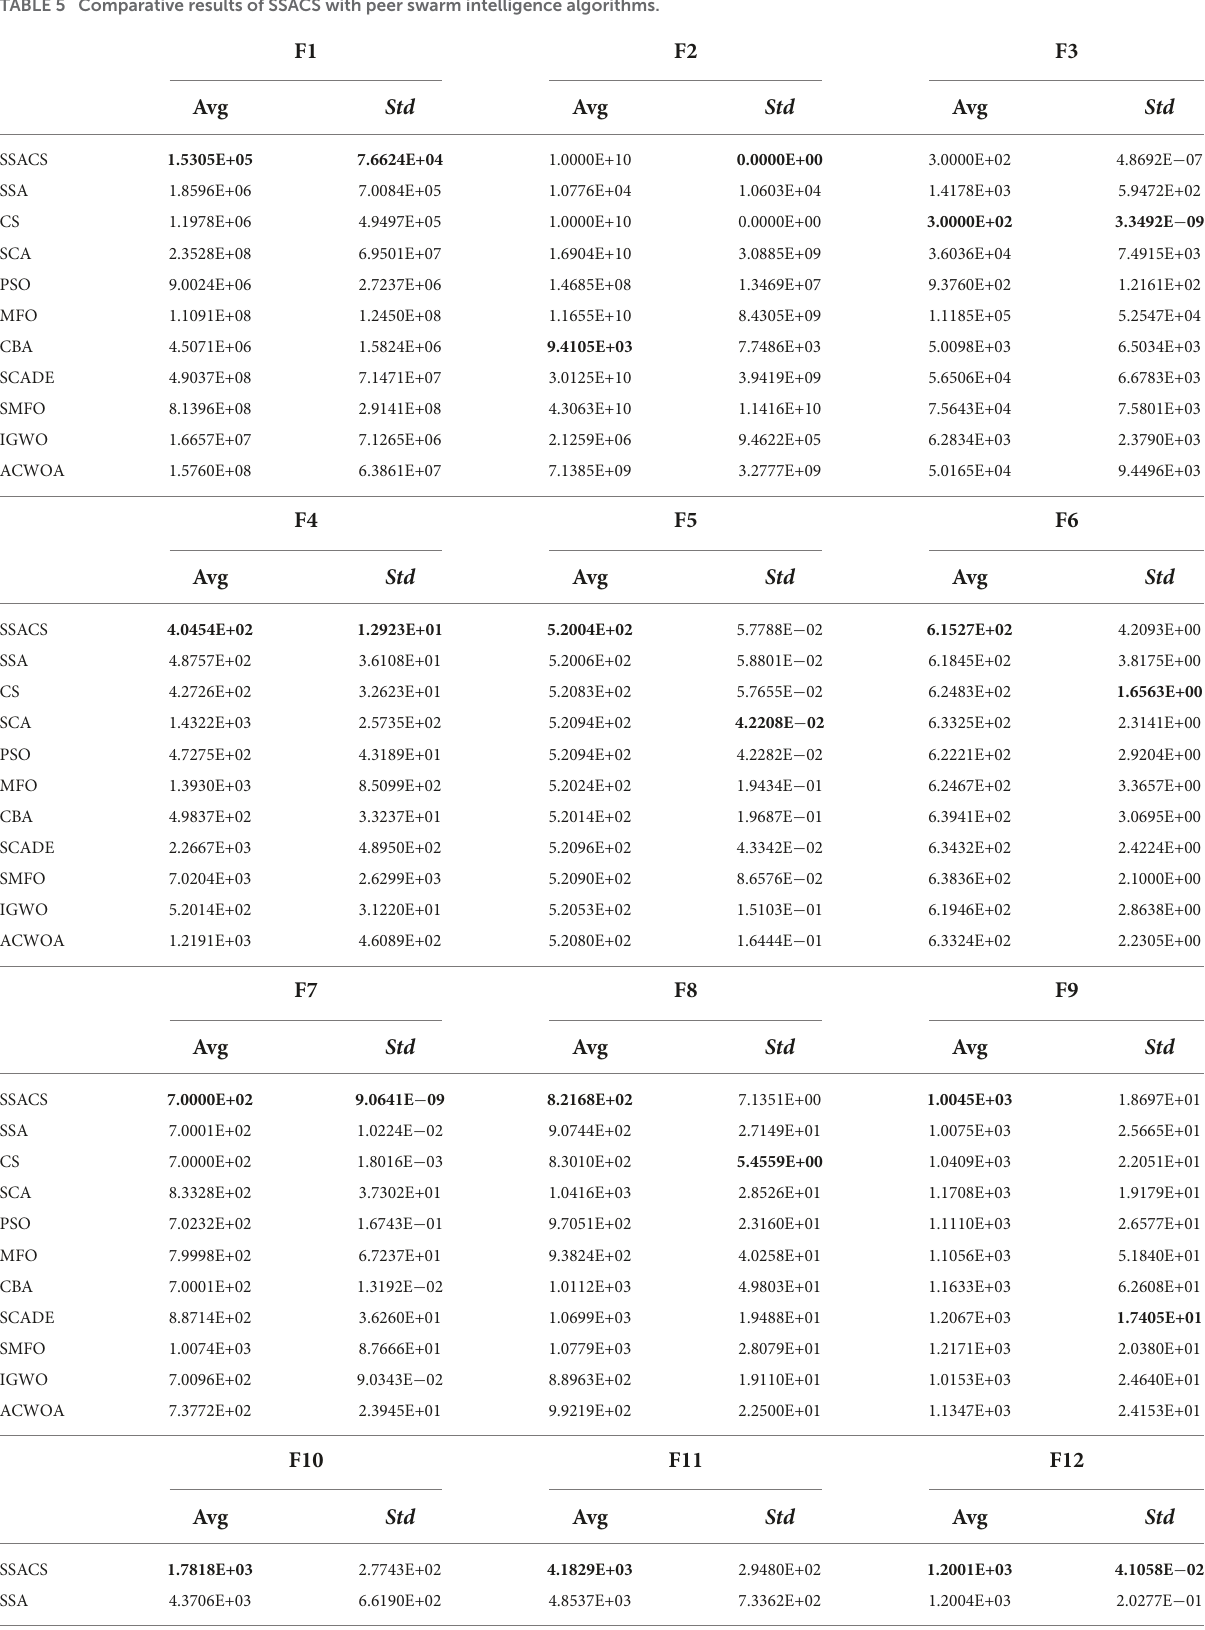
TABLE 5 Comparative results of SSACS with peer swarm intelligence